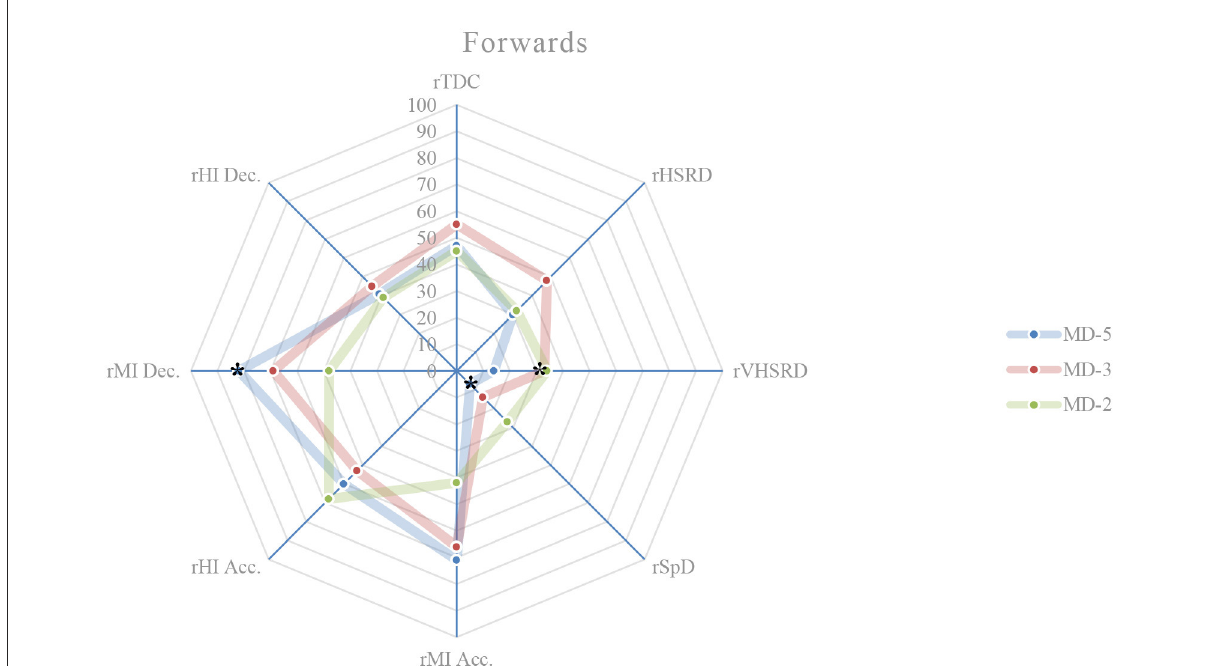
FIGURE5 Daily external load (based on MRef) of forwards. *Location of the significant differences, p < 0.05.